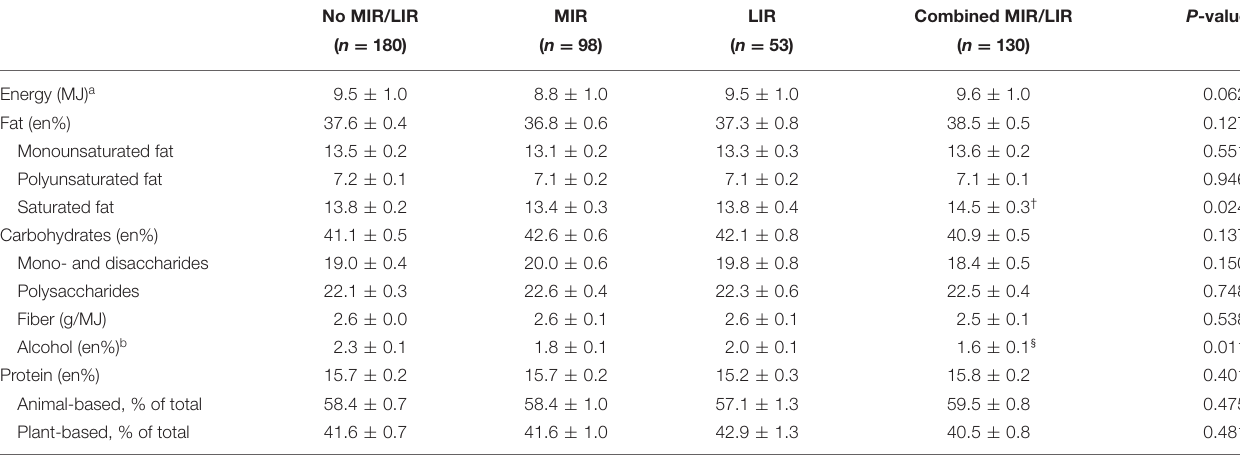
TABLE 3 | Habitual dietary intake from FFQ according to insulin resistance